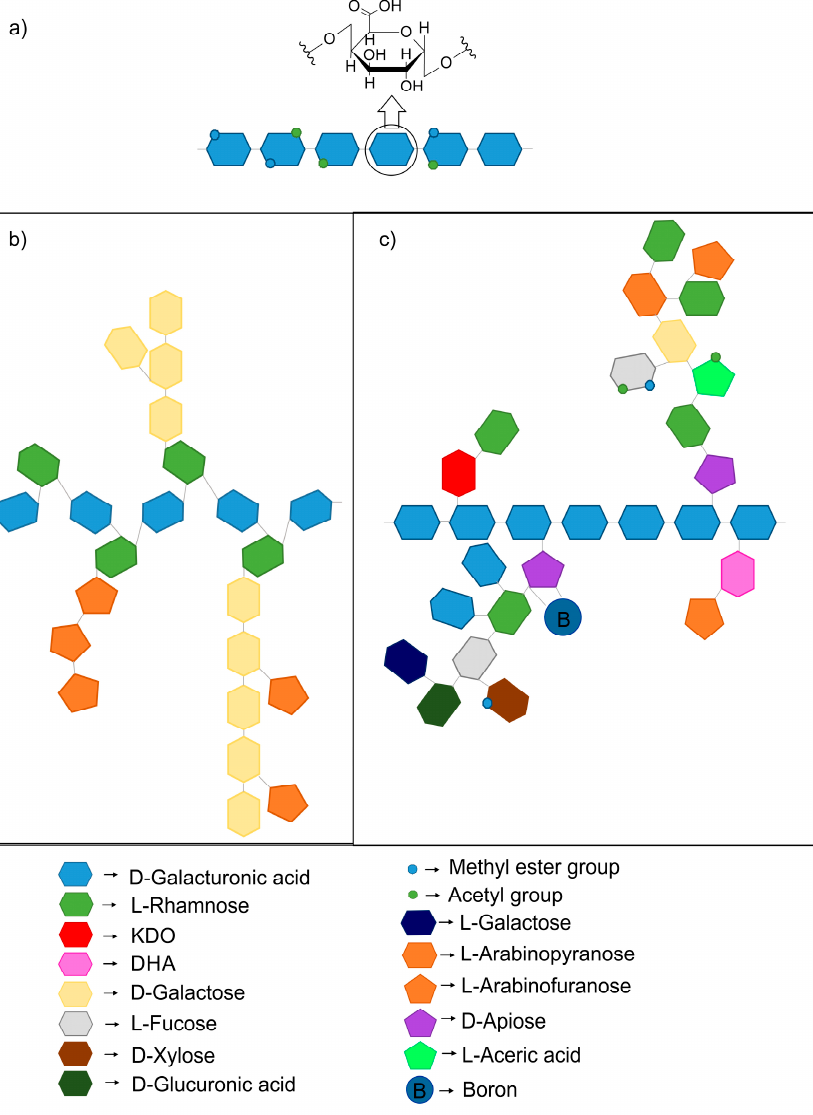
Figure 1. Schematic structure of pectin polysaccharides: ( a ) homogalacturonan; ( b ) rhamnogalacturonan I; ( c ) rhamnogalacturonan II, based on: [1,36,37].